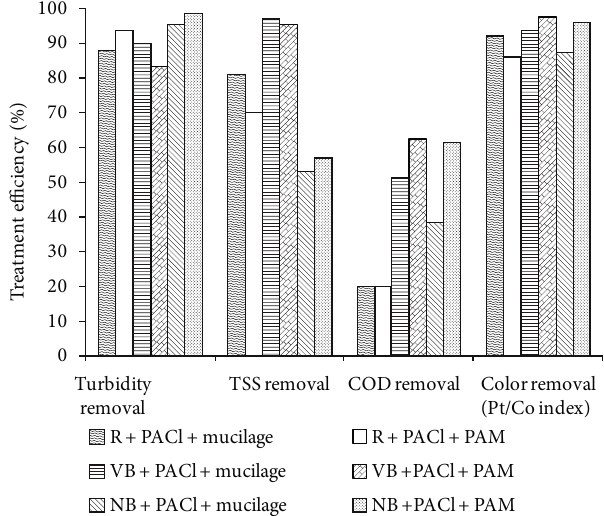
Figure 6: Pollutant removal of mucilage and PAM in combination with